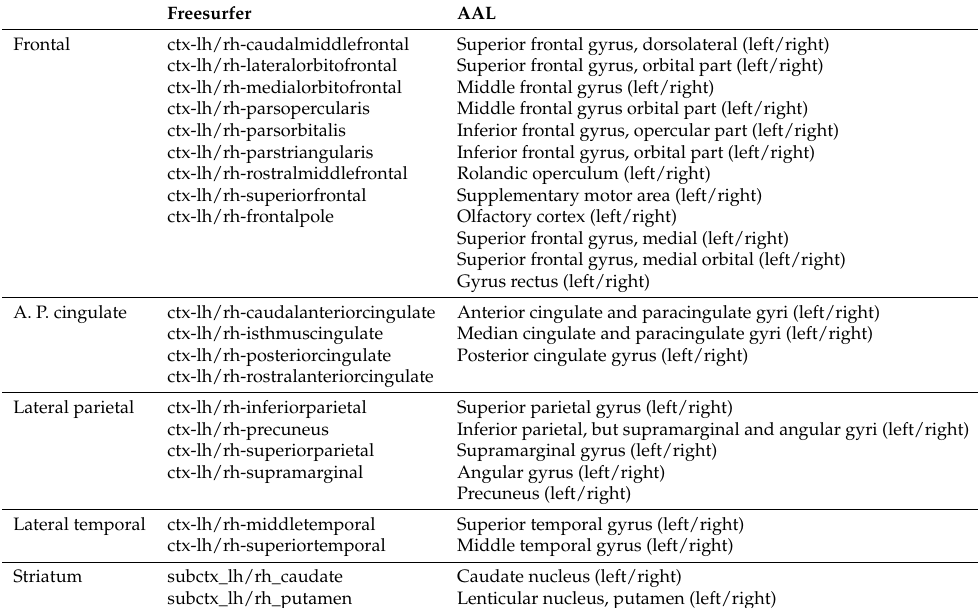
Table A1. ROI comparison between Freesurfer and AAL at the lobe level. rh and lh denotes the right hemisphere and left hemisphere, respectively. A.P. cigulate means anterior posterior